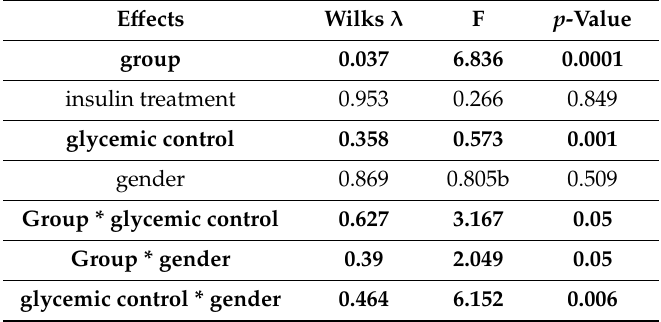
Table 4. Multivariate test of M-ANOVA. Bold in order to further highlight statistically significant values.